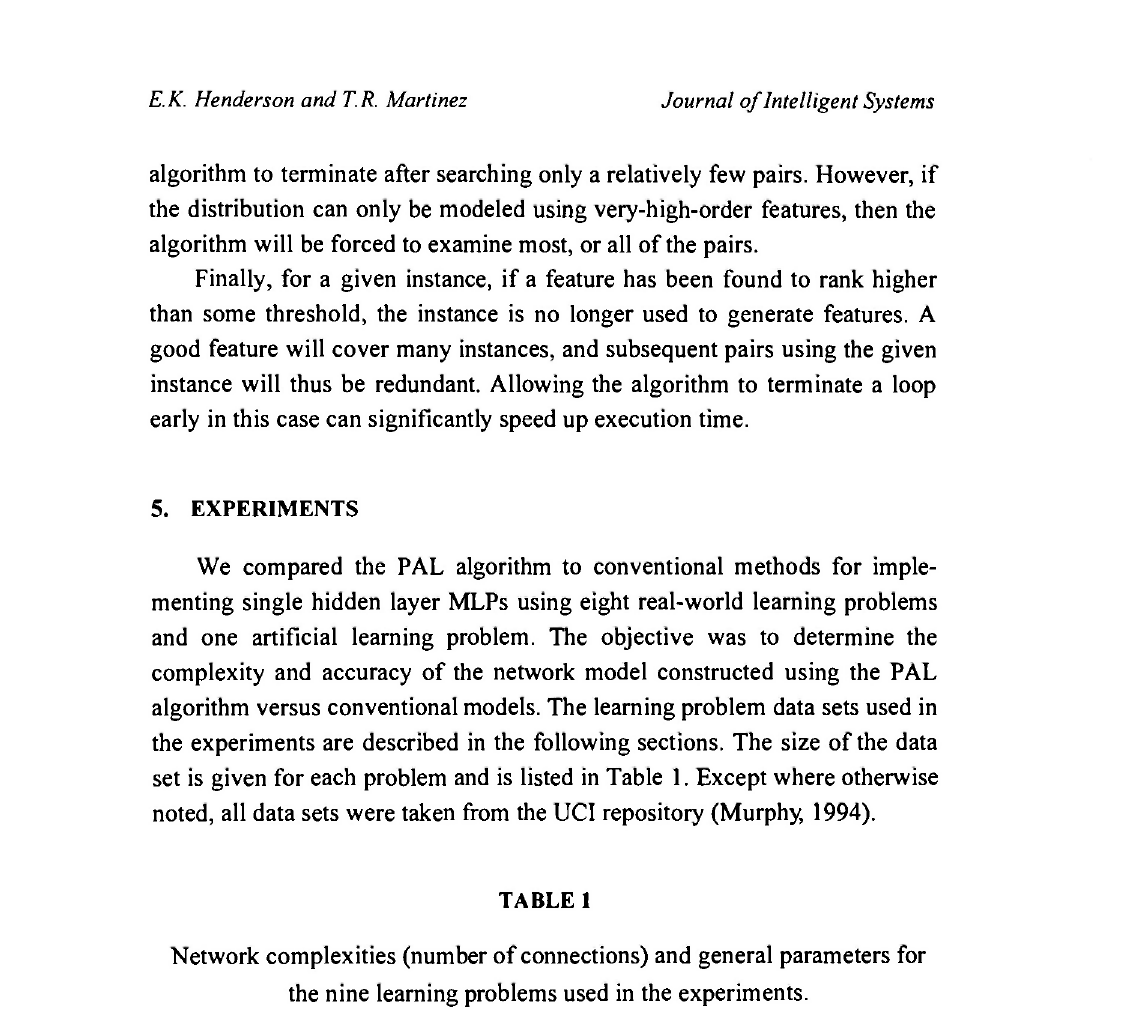
Network complexities (number of connections) and general parameters for the nine learning problems used in the